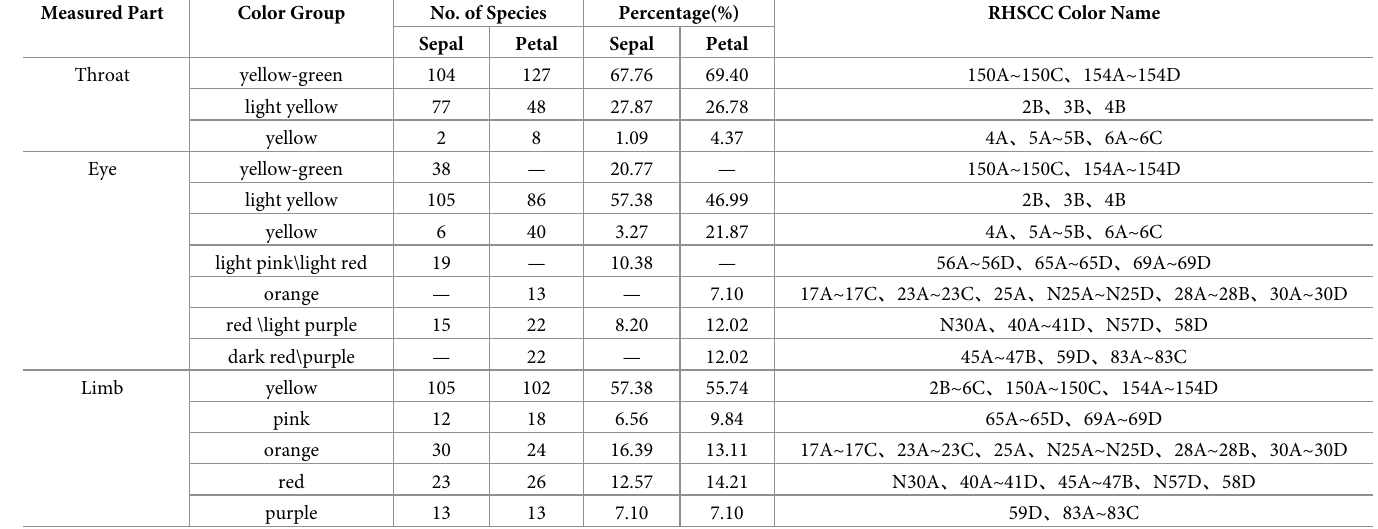
Table 1. The clusters of Hemerocallis sepal and petal color phenotypes. Measured